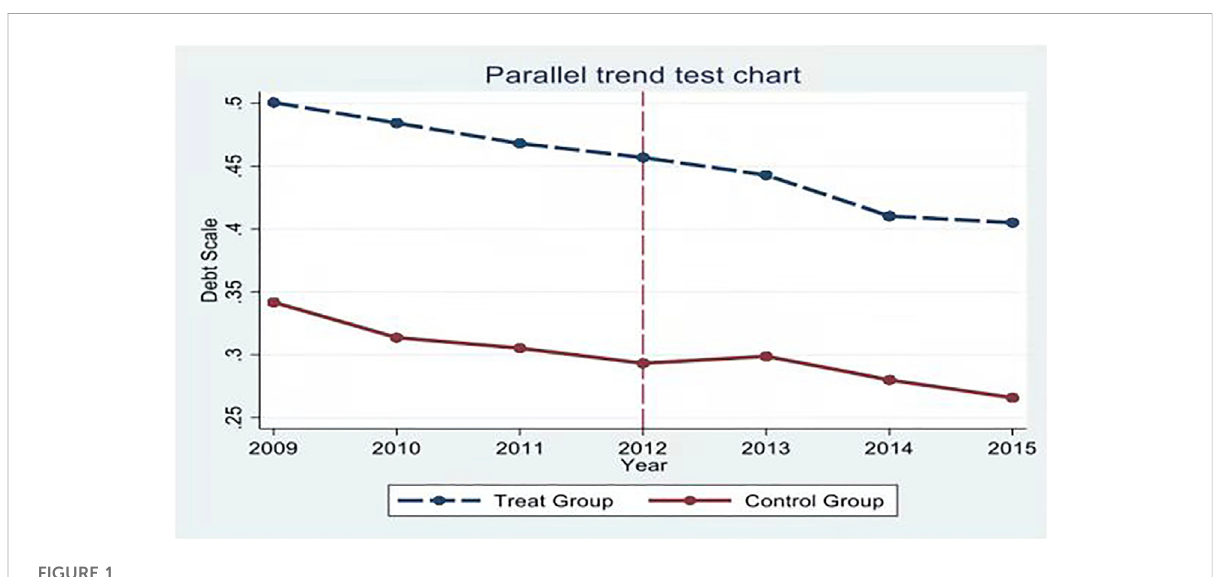
FIGURE 1 Parallel trend test